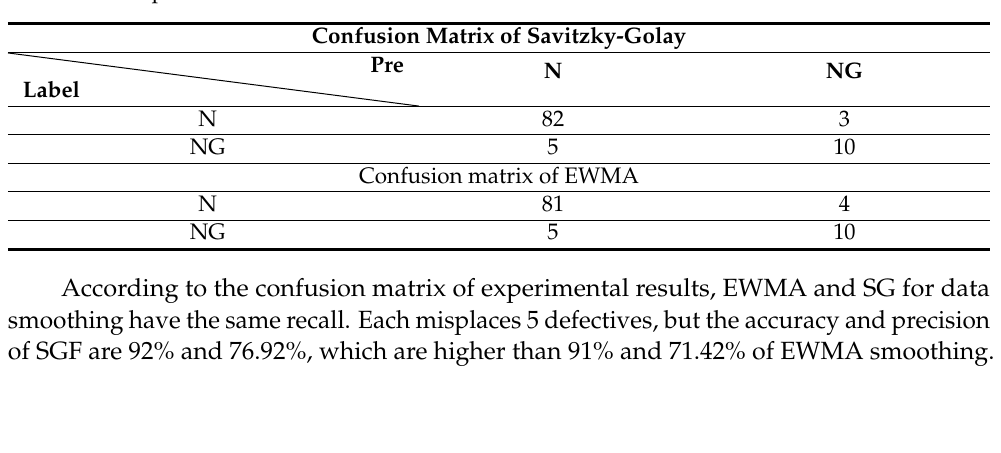
Table 12. Comparison of random